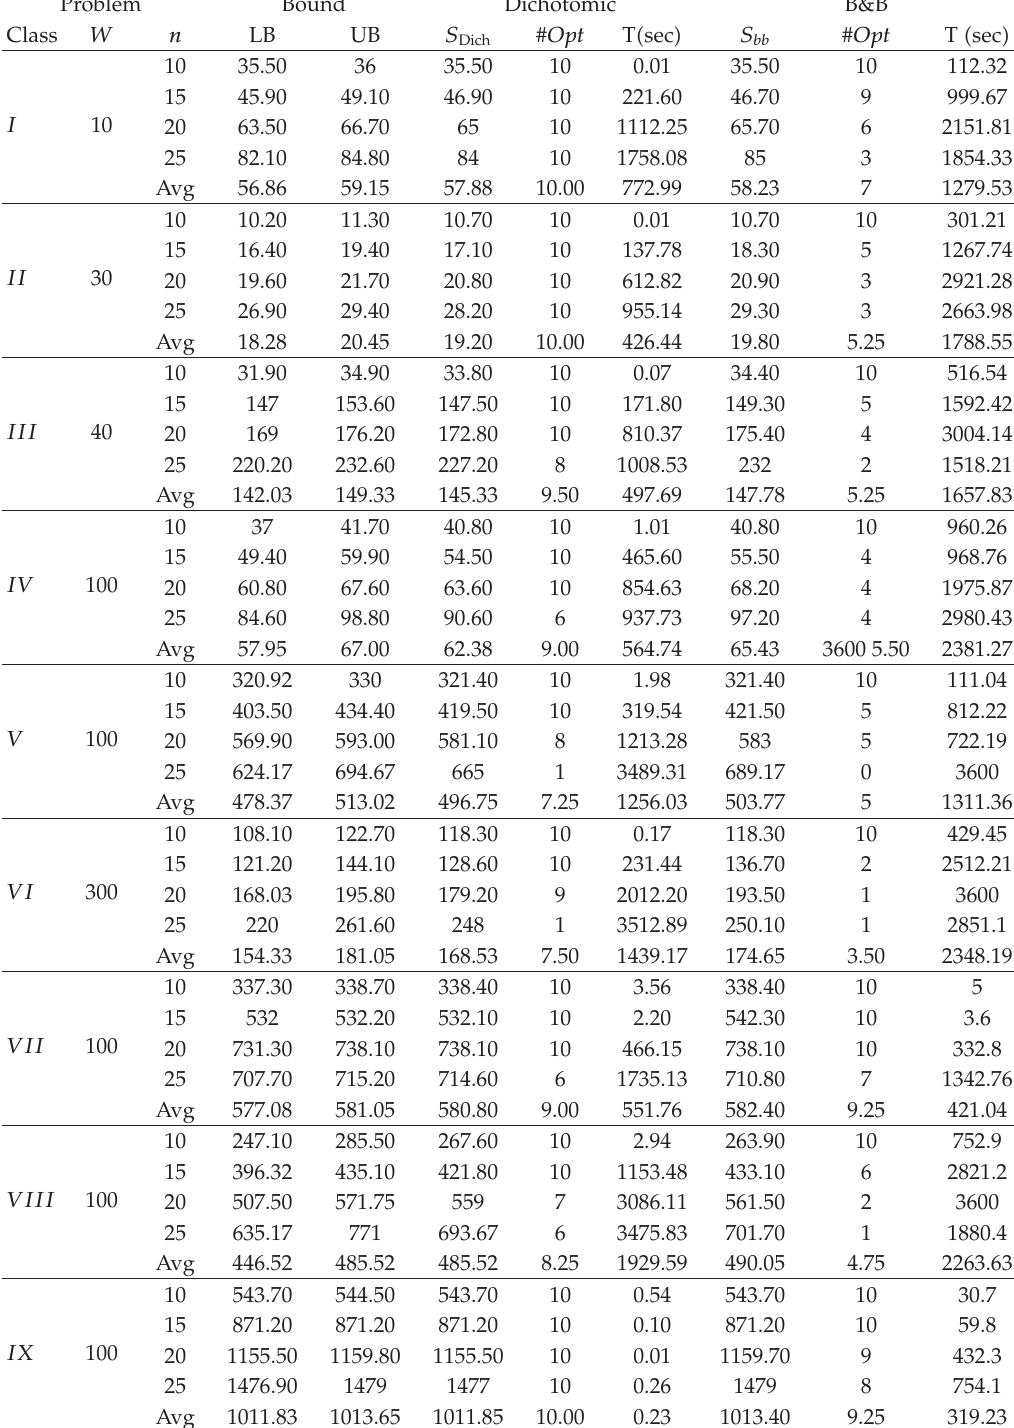
Table 4: Results obtained by dichotomic and branch-and-bound algorithms on random instances.